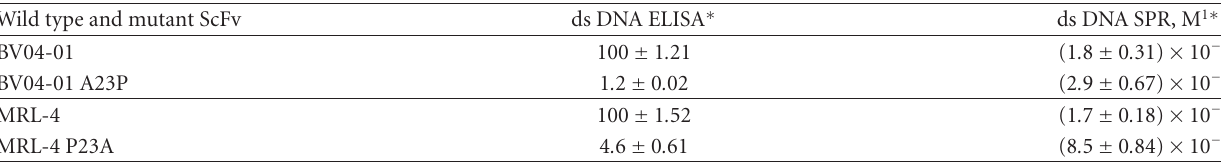
Table 1: A ffi nity constants of BV04-01 and MRL-4 ScFvs and their mutants determined by SPR.